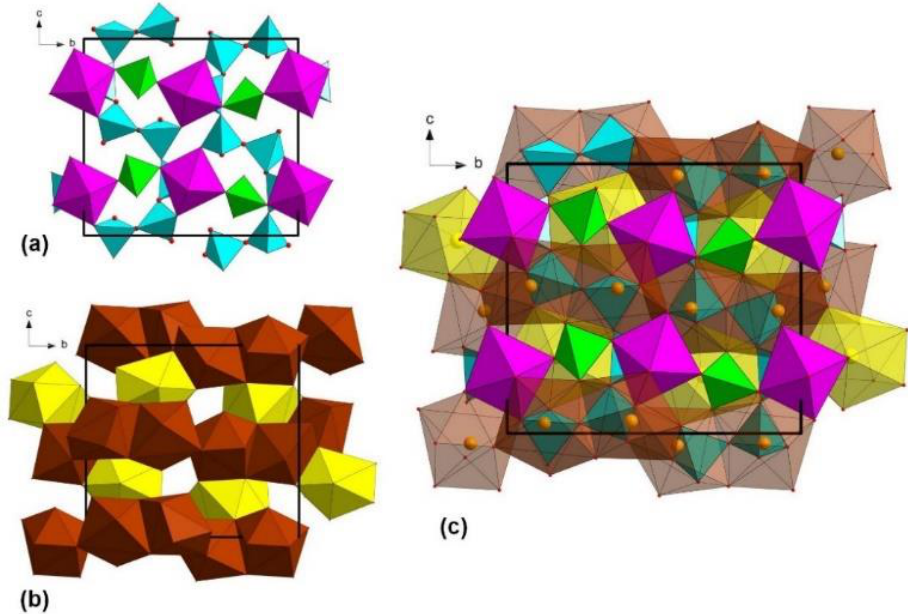
Figure 4. The crystal structure of kesebolite-(Ce) viewed along the a axis. Square corresponds to the unit-cell edges. ( a ) Si-tetrahedra are colored in turquoise; As-tetrahedra and Mn-octahedra in green and pink, respectively. ( b ) A 1 and A 2 polyhedra (Ca) in red, A 3 (Ce) in yellow. ( c ) The total structure with all polyhedra shown (partly transparent). Ca atoms as orange spheres, Ce in yellow. Table 6. Atoms, site-occupancy factors (s.o.f.) and fractional atomic coordinates of kesebolite-(Ce).